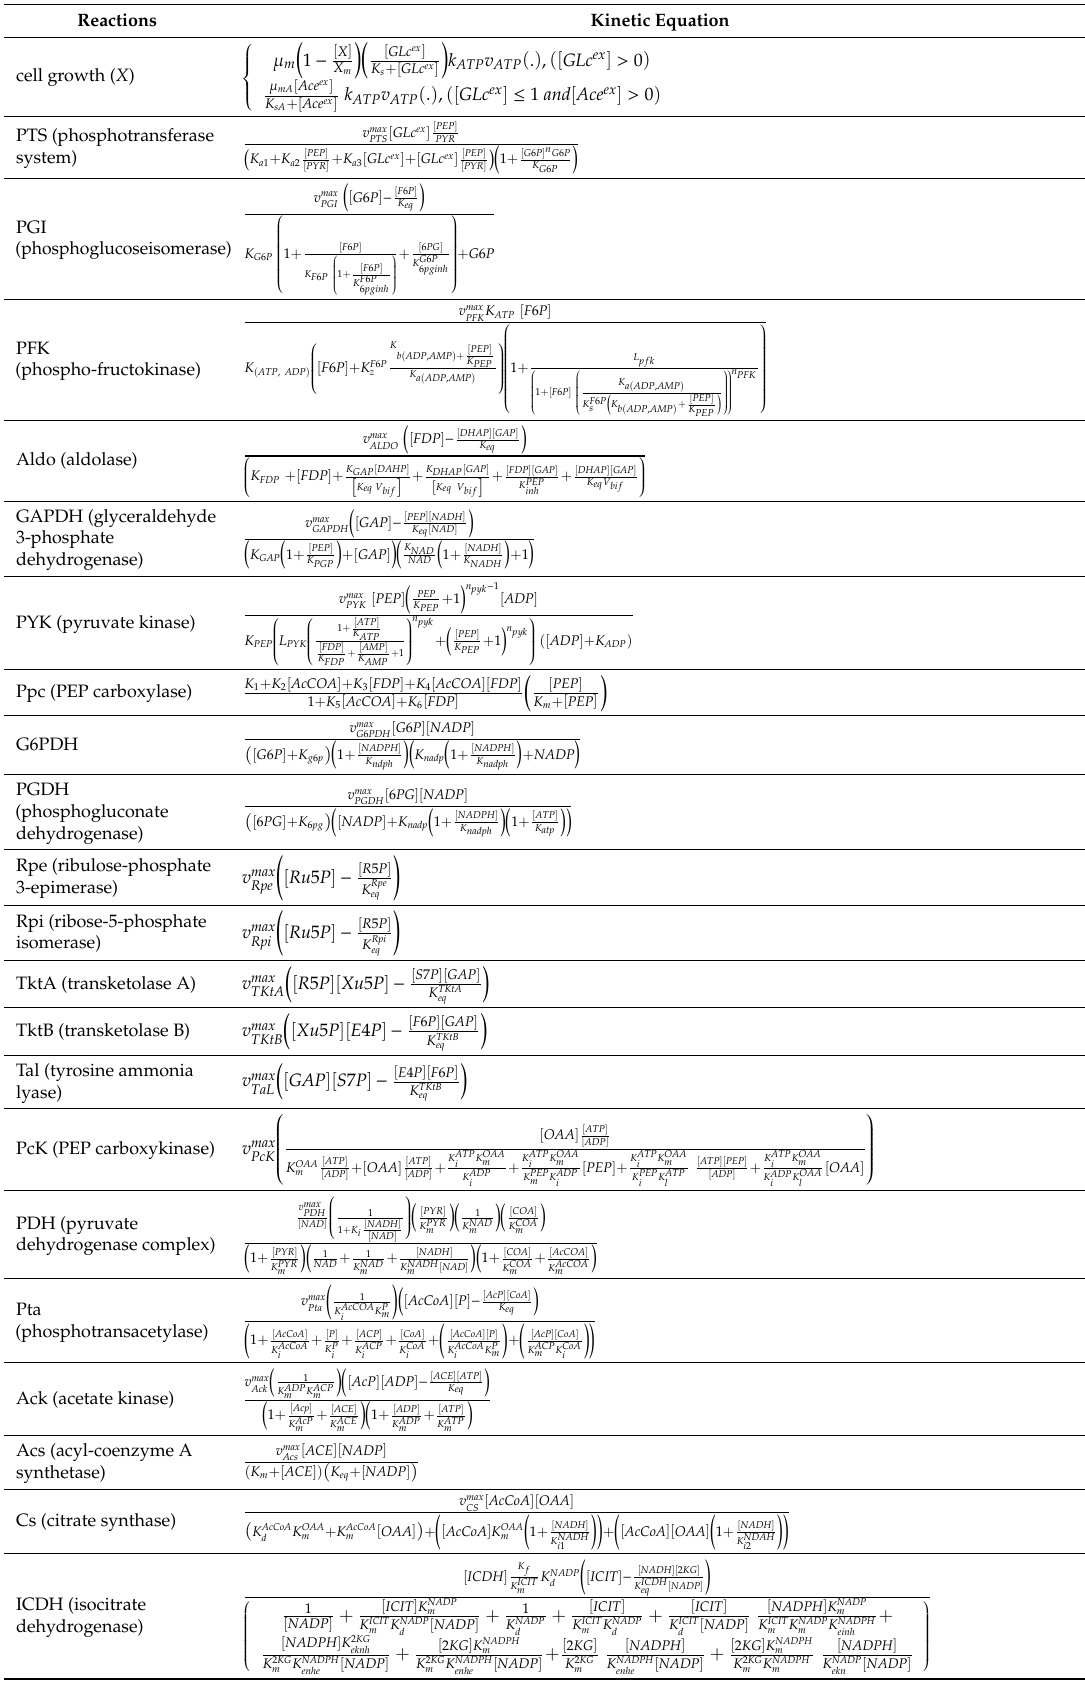
Table A2. Reaction rate